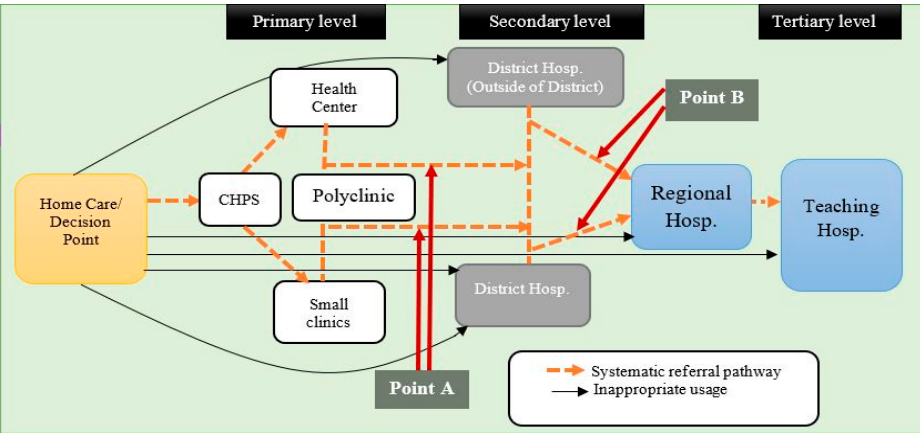
Figure 1. The referral pathway in Ghana. Source: Author’s elaboration, Adapted from BASICS II and GHS [9]. However, from the supply side of the health system, the standard procedure for referral is often either absent or hardly put to use in many health facilities in Ghana [5,6]. Some studies in Ghana [10] and elsewhere in sub-Saharan Africa (Uganda, Zimbabwe) [11,12] indicate that disregard for the referral system is associated with inadequate emergency transportation services and